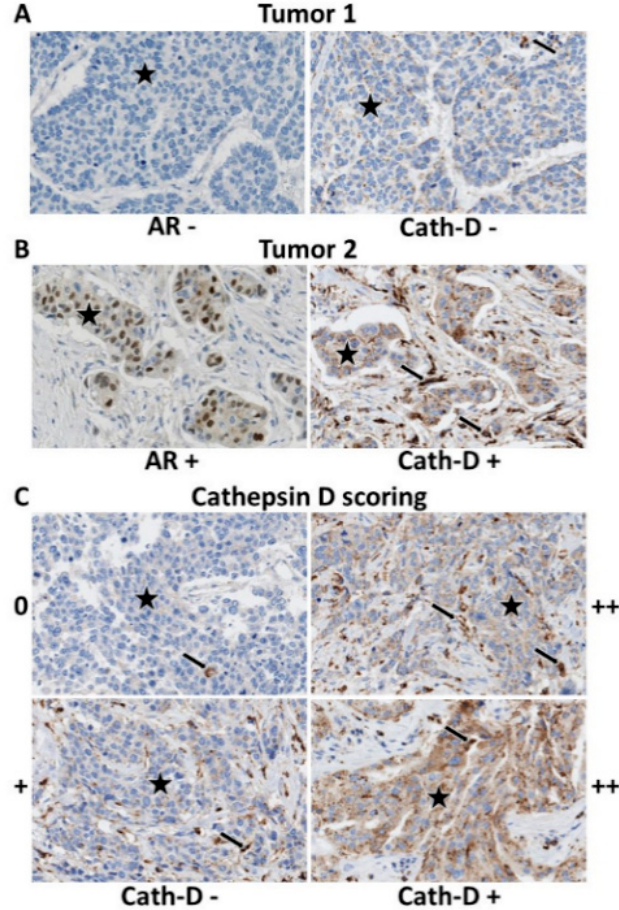
Figure 1. Representative images of TNBC that express or not AR and Cath-D. Immunohistochemistry analysis of TNBC tumor microarrays (TMAs). ( A ) AR- / Cath-D − tumor. ( B ) AR +/ Cath-D + tumor. ( C ) Cath-D scoring in TNBC cancer cells: 0 (none), + (weak), ++ (moderate), +++ (strong). Magnification × 200. Stars: tumor cells; arrows: macrophages. 2.4. Triple-Negative Breast Cancer (TNBC) Cell Lines, Enzalutamide Treatment, and Western Blotting The MDA-MB-453 and MDA-MB-468 cell lines were obtained from SIRIC Montpellier Cancer. The SUM159 cell line was from Asterand Bioscience (Royston, U.K. & Detroit, MI, USA). The MDA-MB-231 cell line was previously described